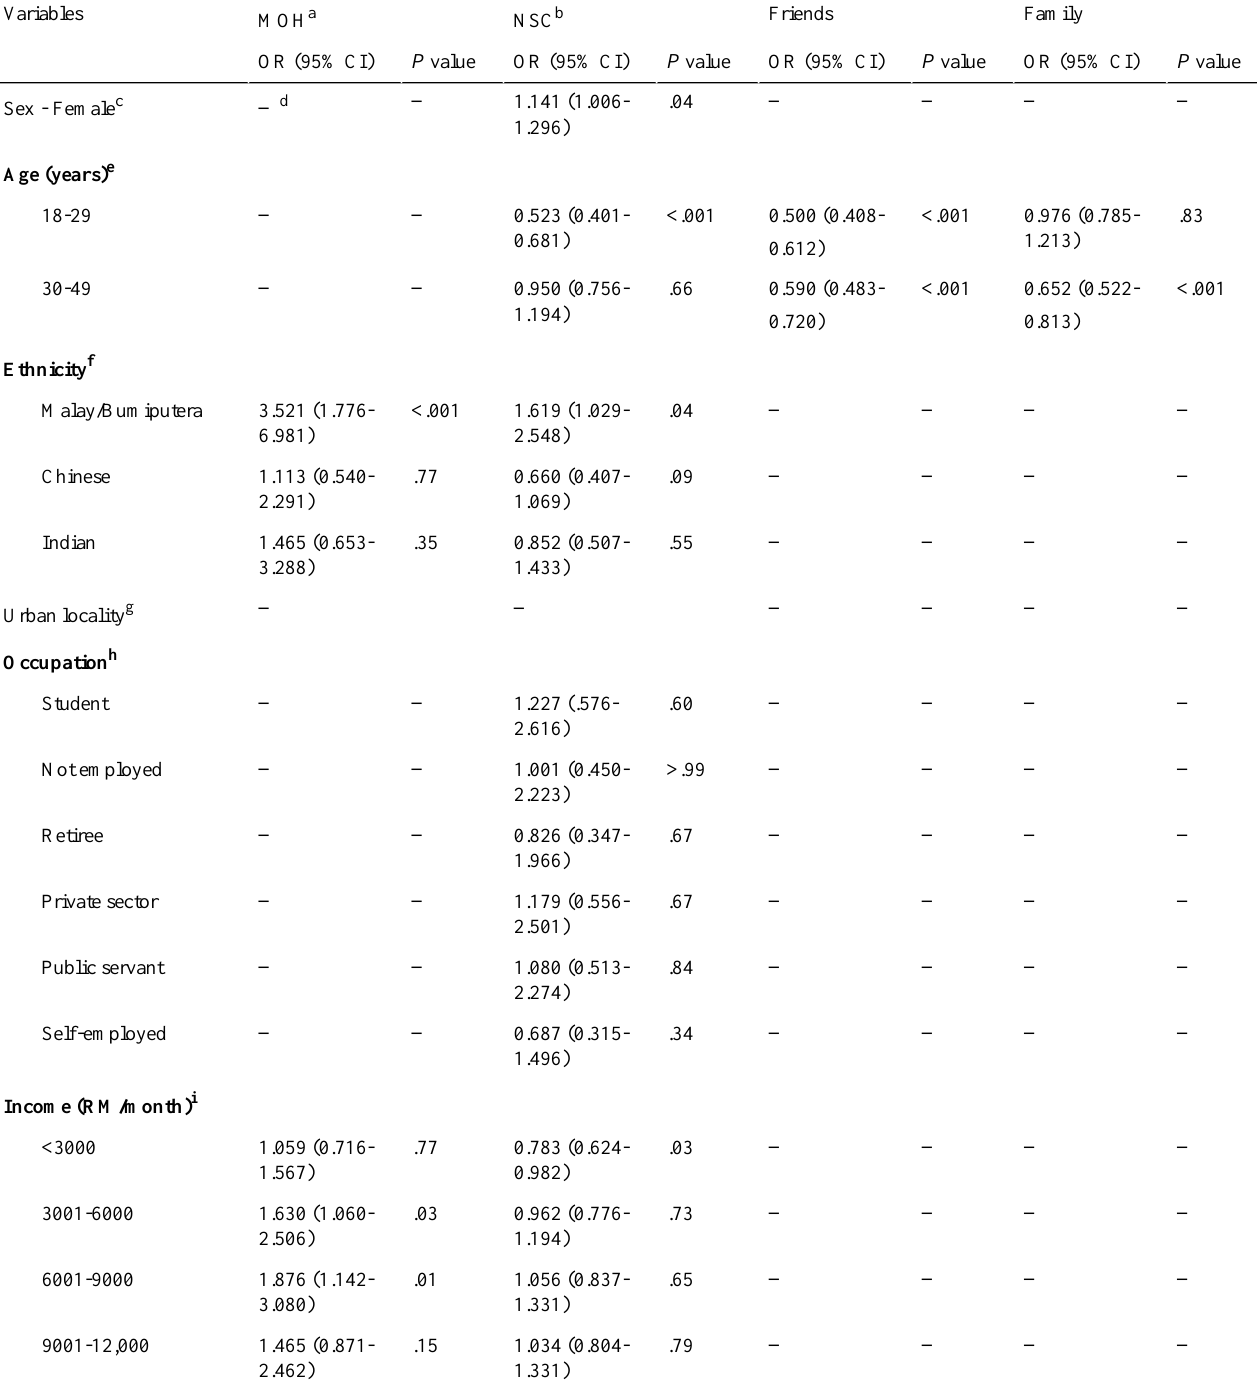
Table 4. Factors related to the use of COVID-19 interpersonal and health authority information sources.